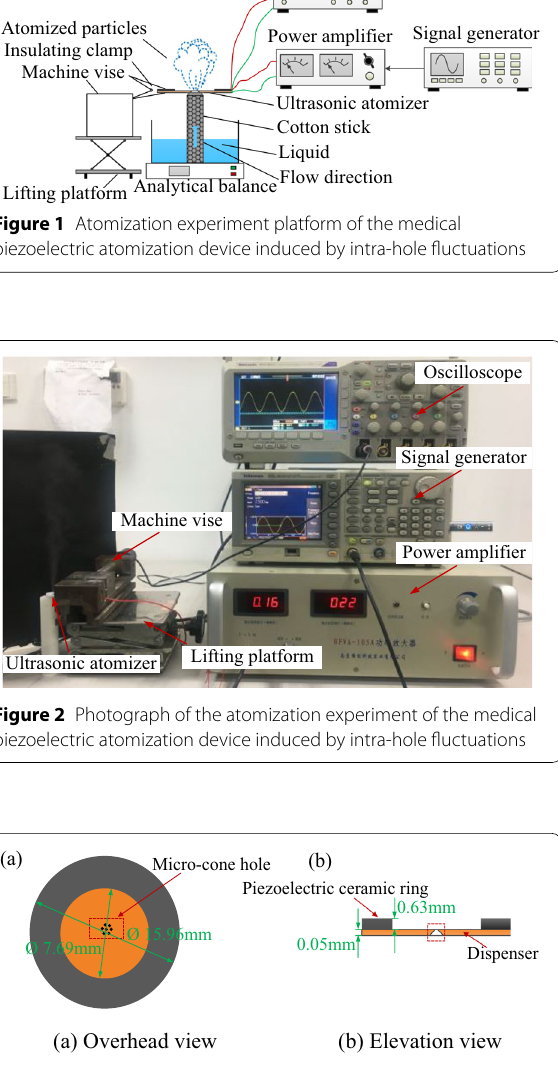
Figure 3 The schematic diagram showing the structure and parameters of the atomizer piece used in this work